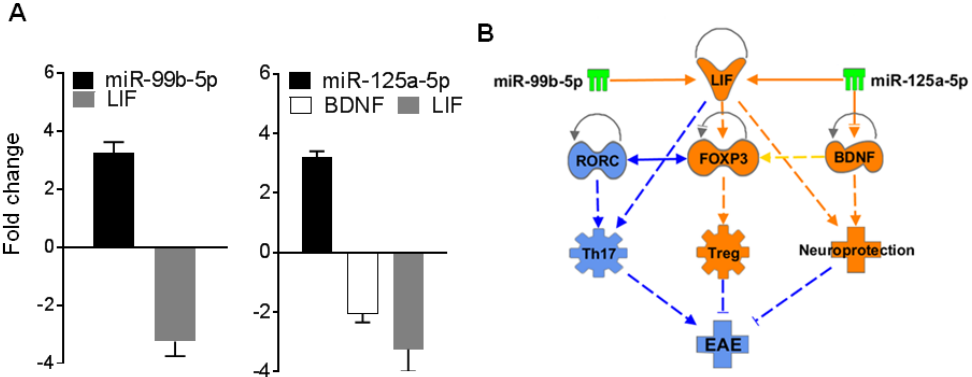
Figure 7. ( A ) Total RNA isolated from splenocytes of EAE mice at peak phase of the disease was tested by qRT-PCR for the indicated miRNAs and their potential gene targets. The results are expressed as ‘Fold change’ over a housekeeping gene; ( B ) IPA analysis of BDNF, LIF, and other mediators and pathways pertaining to EAE that are modulated by miR-99b and miR-125a.